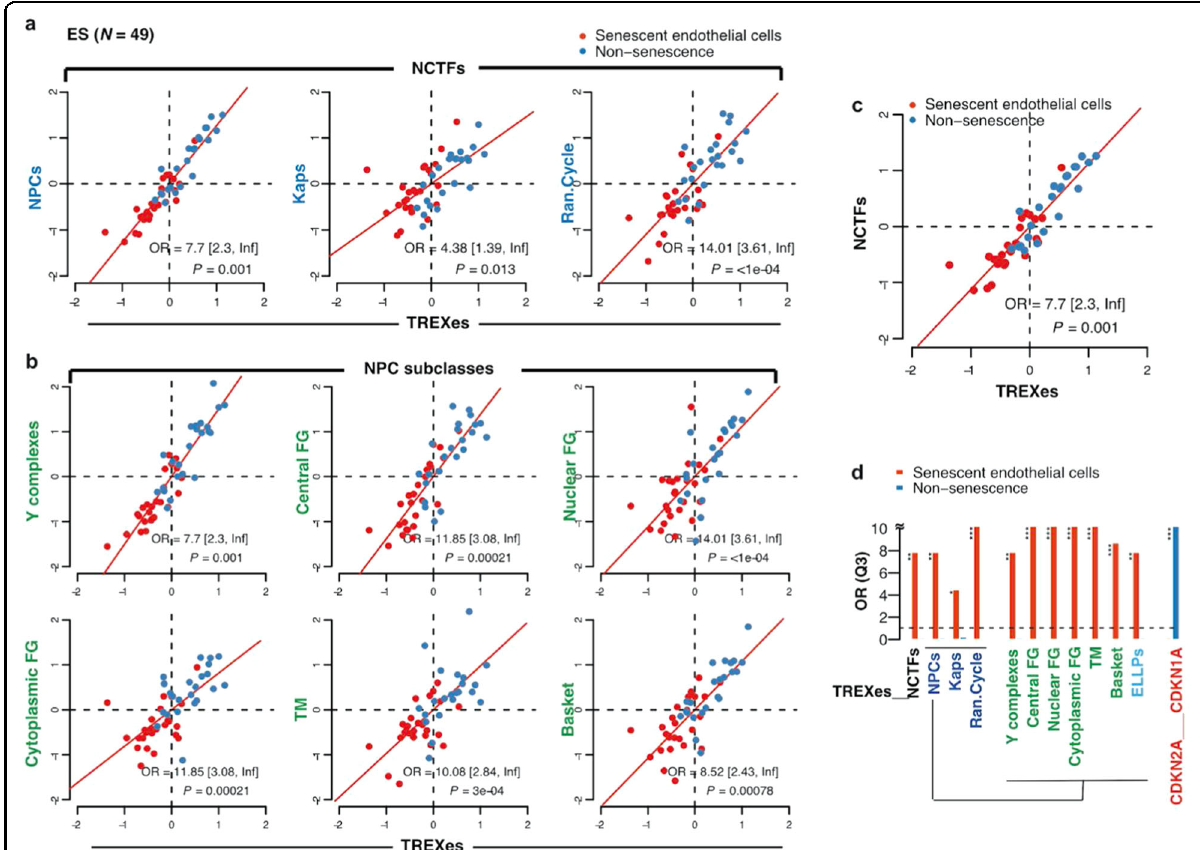
Fig. 2 TREXes and NCTFs show distinctive enrichment patterns in endothelial senescent cells. Analysis of two-dimensional differential mean expression of TREXes and NCTFs between endothelial senescent cells (red dots) from 8 screened endothelial aging studies and their young counterparts (blue dots). After gene set mean expression levels were z-standardized, the odds ratio (OR) and statistical signi fi cance were calculated by Fisher 2-tailed exact test. Horizontal and vertical dashed lines are median points for the TREXes and NCTFs. Endothelial senescent cells were more likely to be in the lower left-hand quadrant (Q3), and the odds ratios are shown with 95% con fi dence intervals and p -values. a TREXes and subclasses of NCTFs: NPCs, Kaps, and Ran cycle genes. b TREXes and six distinct subclasses of NPC: Y complexes, central FG, nuclear FG, cytoplasmic FG, TM, and basket. c Collective TREXes and NCTFs of endothelial senescent cells. d Bar plot representing the odds ratios (Q3) of NCTFs and subclasses and TREXes, as shown in ( a ) through ( c ). The red bar indicates the odds ratio (Q3) of the senescent cells, and the blue bar indicates the odds ratio of the nonsenescent cells. ES endothelial senescence, Kaps karyopherin, FG phenylalanine – glycine repeat, TM